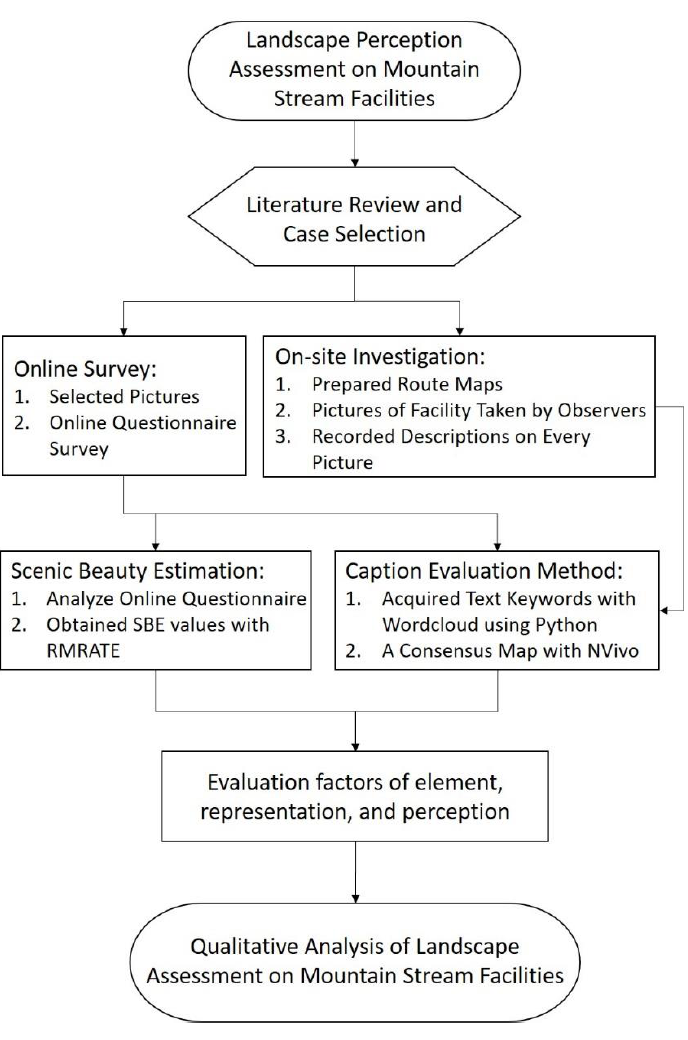
Figure 1. Research flow chart.